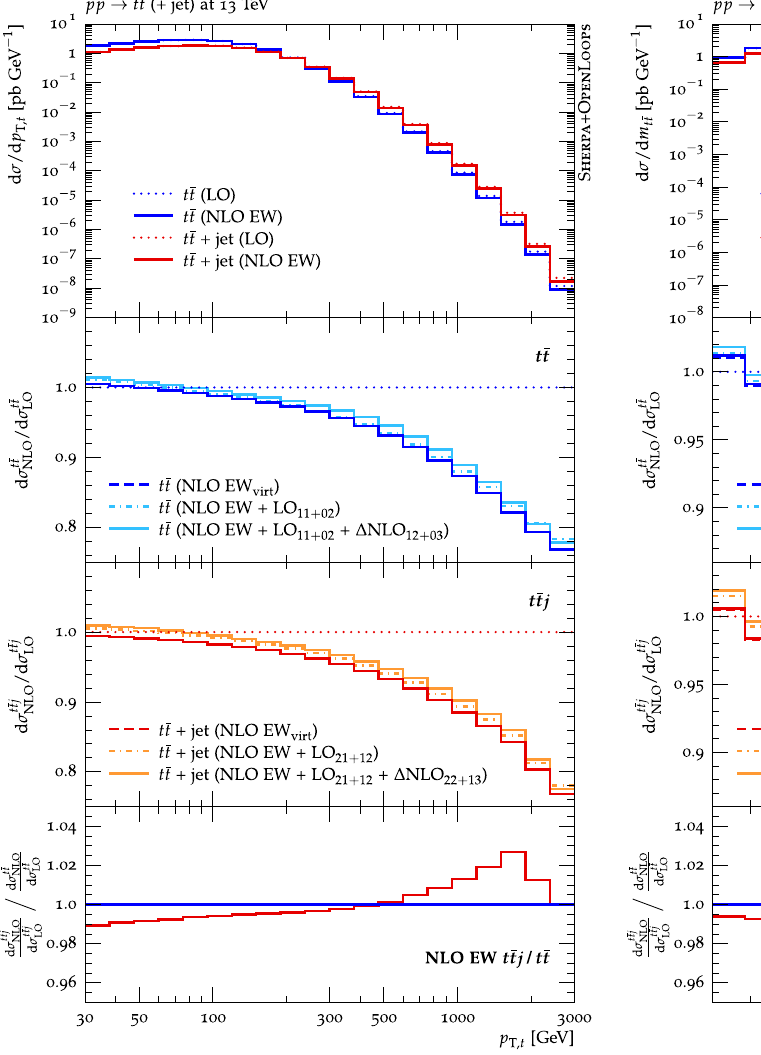
Fig. 1 Top quark transverse momentum (left) and top-antitop invari- ant mass (right) in inclusive t ¯ t production (blue) and t ¯ t + jet produc- tion (red) at NLO EW at 13TeV at the LHC. In t ¯ t + jet we require p T > 30GeV. The top panel shows the differential cross section, while the three lower panels show, from top to bottom, the subleading Born and higher-order corrections to inclusive t ¯ t production and t ¯ t + jet pro- duction, respectively. Subleading Born and one-loop contributions are